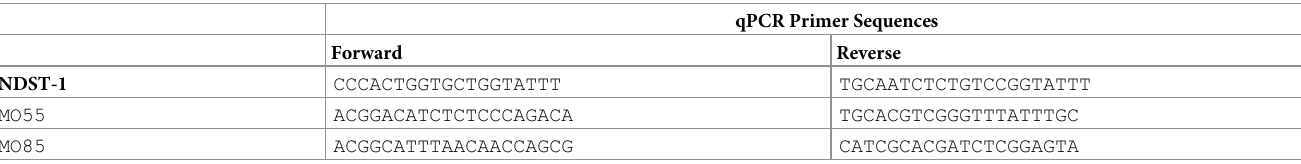
Table 1. List of primers used in this